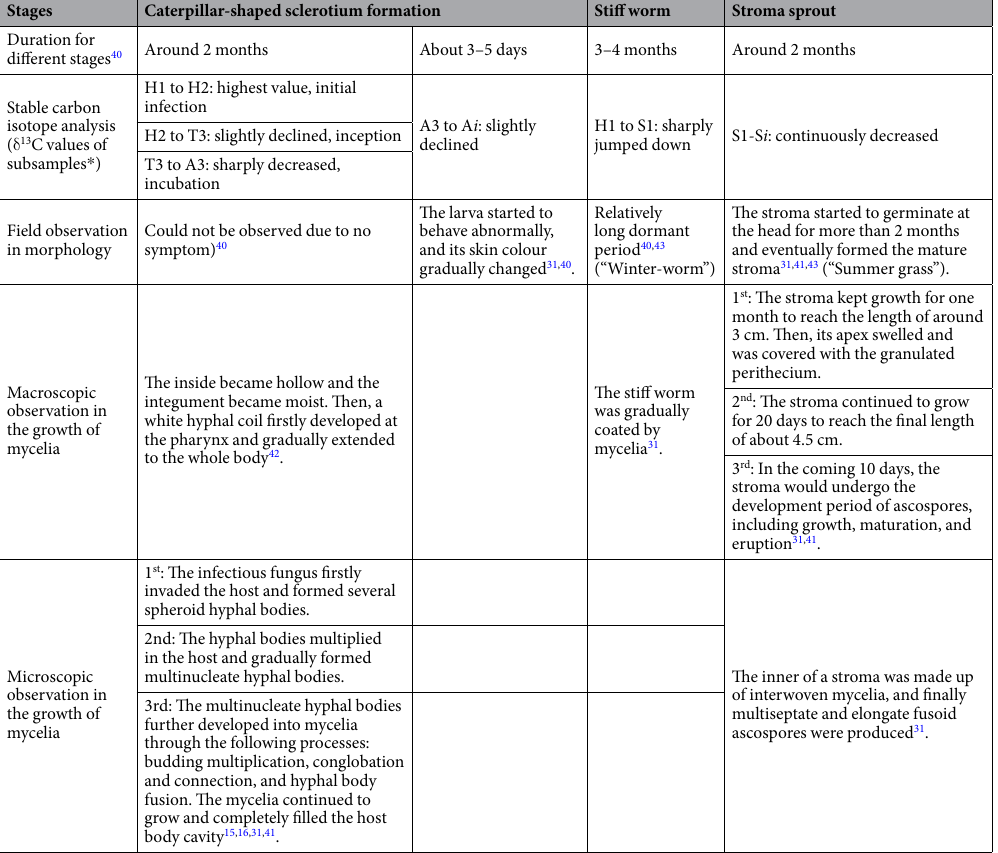
Table 1. Comparison between stable carbon isotope analysis and conventional approaches applied in studying the development of Cordyceps sinensis . * S1 to S i , H1 to H2, T1 to T3, and A1 to A i are the subsamples from the stroma, head, thorax, and abdomen according to their positions, respectively. The italic lower case letter i represents the section numbers of the stroma and abdomen,